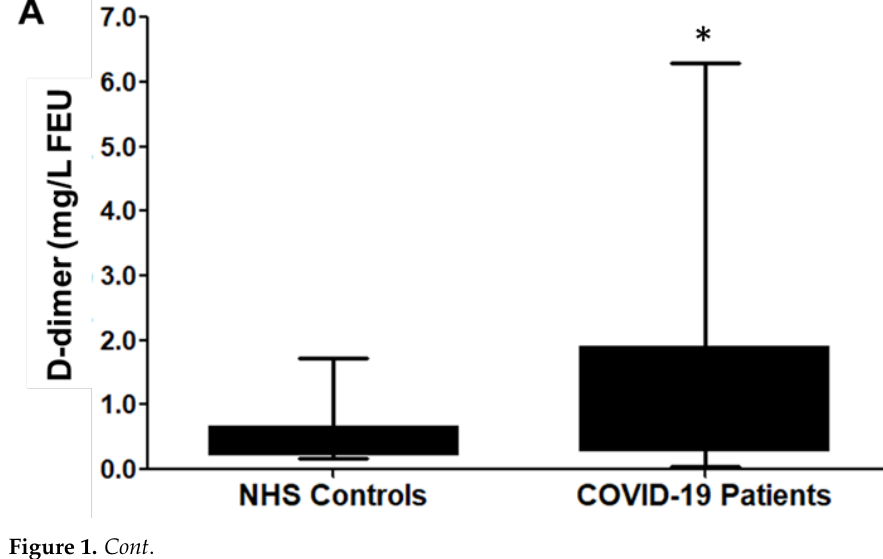
Figure 1. D-dimer in COVID-19 patients. The graphs represent the D-dimer concentration in mg/L FEU± SD. ( A ) D-dimer levels in the blood samples of COVID-19 patients ( n = 148) and in never- infected human subjects (NHS, n = 309 A * p = 0.0027 were obtained in COVID-19 vs. NHS. A com- parison analysis was carried out using the Mann – Whitney test. ( B ) D-dimer levels in COVID-19 patients with mild ( n = 66), moderate ( n = 48), and severe ( n = 34) infection were highly significant with a, * p < 0.05 (95% CI −2.285 to −0.04205) vs. mild infection ; ** p < 0.05 (95% CI −2.591 to −0.1751) vs. moderate infection; and ** p < 0.001 (95% CI −3.243 to −1.850) vs. severe infection. Box and Whisker show the Min to Max values with median ±SD. Comparison analysis was performed via the one-way ANOVA method, fol lowed by Tukey’s post hoc test. 4.2. D-dimer Can Be Used for COVID-19 Disease Stratification The D-dimer levels were also analyzed regarding the hospitalization status of the COVID-19 patients. The results show that the D-dimer levels were significantly increased between the patient groups with mild infection to moderate infection, and were highest in patients with severe COVID-19 disease ( p < 0.05). 4.3. Variations in D-dimer Concentration Do Not Corroborate with the Age or Gender of COVID-19 Infected Patients